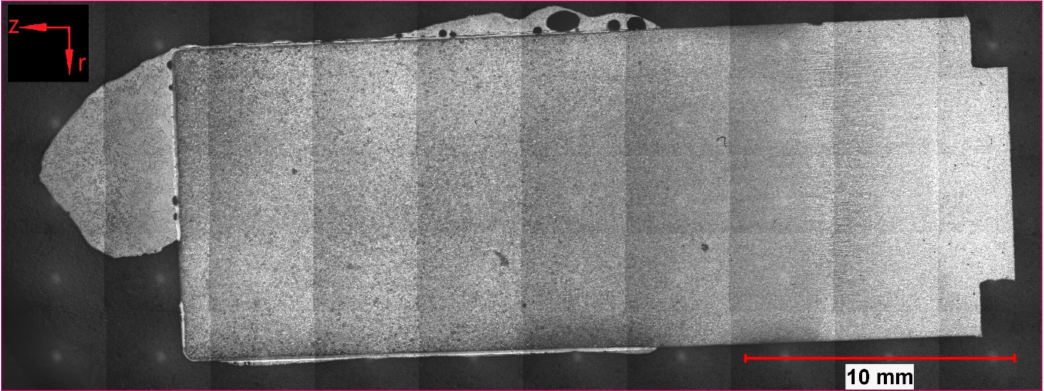
Figure 4. Nital-etched longitudinal area of stagnant sample number 162, submerged for 20 s into hot metal with an equilibrium temperature between scrap core and hot metal of 1230 ◦